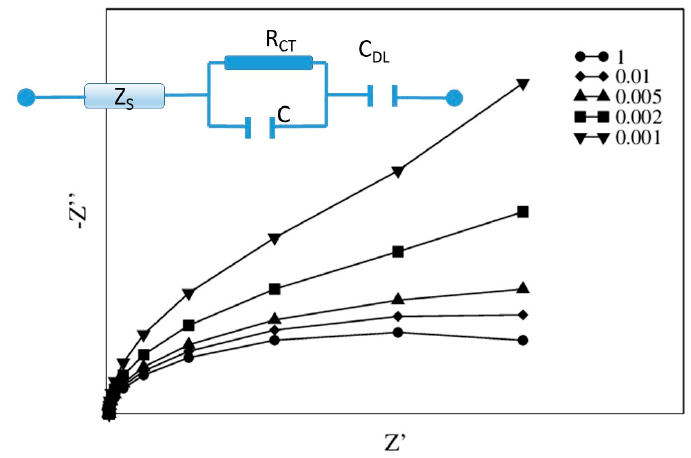
Figure 5. The proposed EEC and the expected Nyquist plot for C DL = C, 0.01C, 0.005C, 0.002C, 0.001C